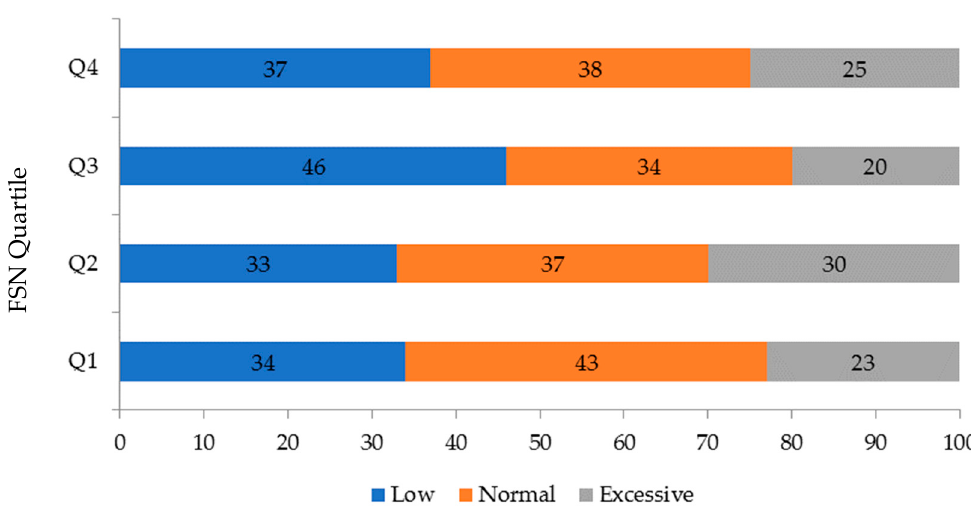
Figure 2. Gestational weight gain according to family support network quartile.